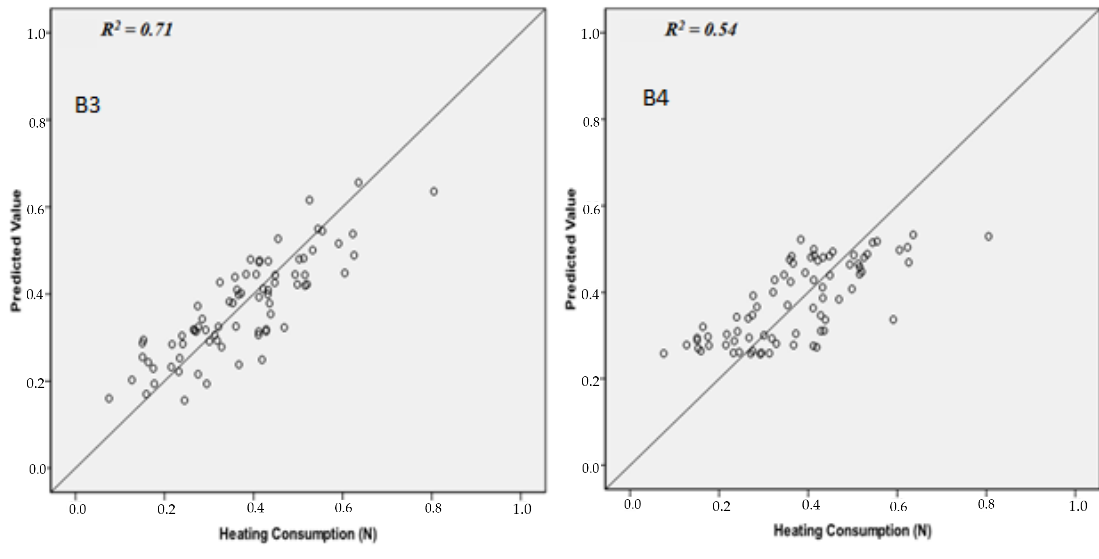
Figure 2. Influence of the ANN configurations on modeling performances.